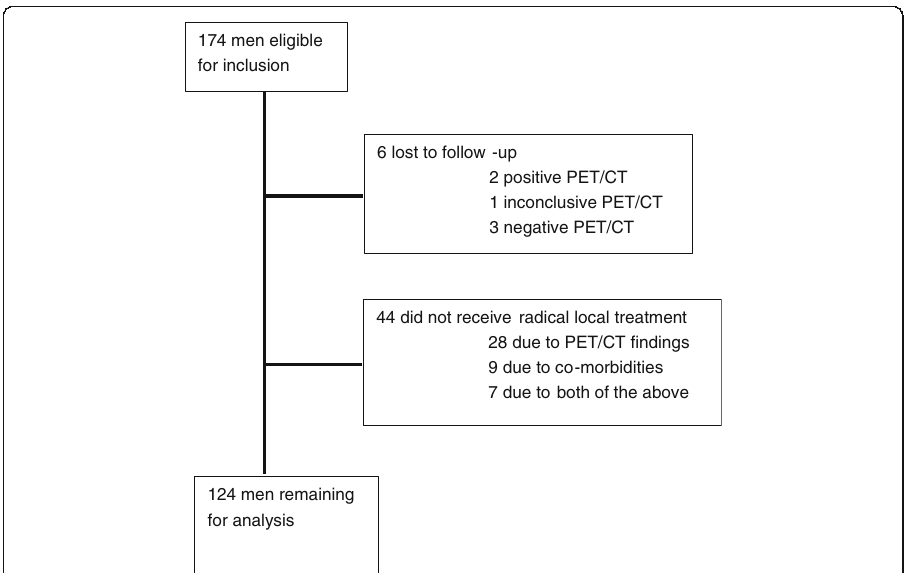
Fig. 1 Inclusion and exclusion flow chart. Abbreviations: PET/CT, positron emission tomography fused with computed